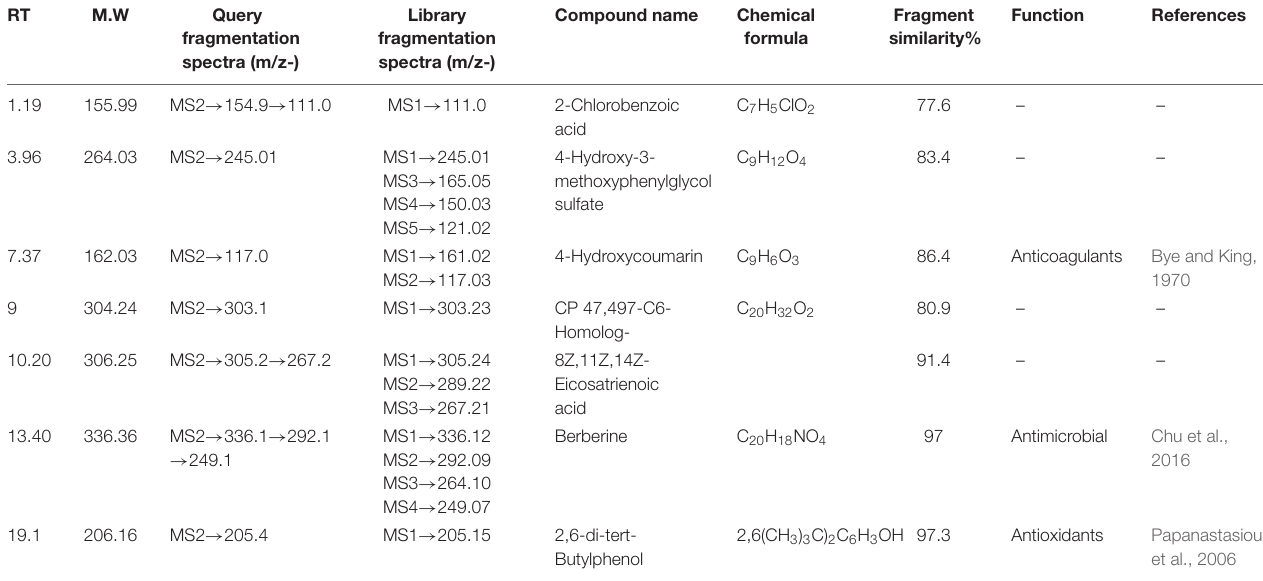
TABLE 6 | One hundred nanomolar BRD4700-treated induced compound in the negative ionization